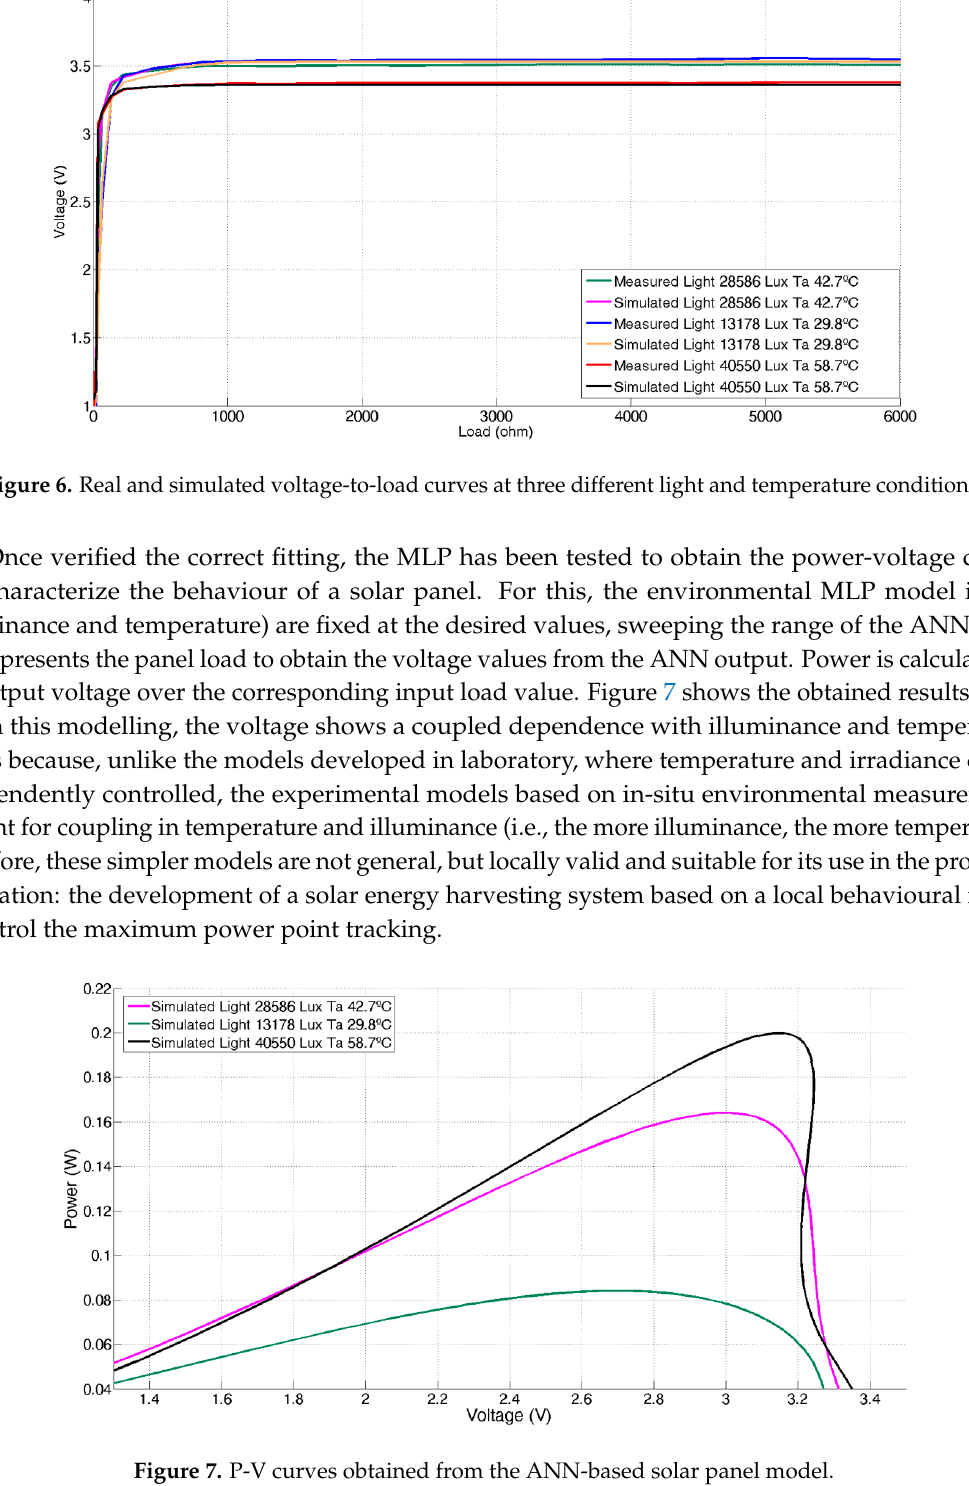
Figure 7. P-V curves obtained from the ANN-based solar panel model.